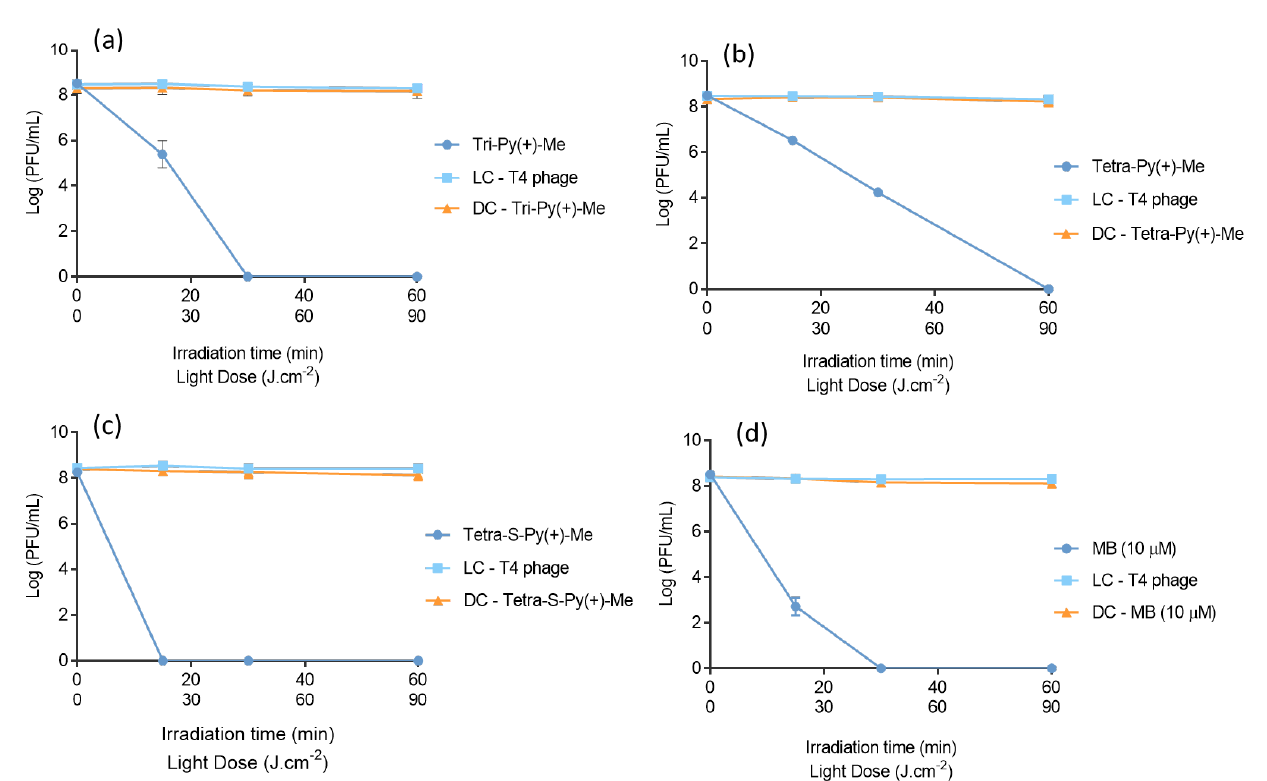
Figure 4. T4-like phage photoinactivation in PBS in the presence of ( a ) Tri-Py(+)-Me, ( b ) Tetra-Py(+)- Me, ( c ) Tetra-S-Py(+)-Me, and ( d ) MB at a concentration of 10 µM and under white light irradiation at an irradiance of 25 mW·cm − 2 . All values represent the average of three independent assays in duplicate. Error bars indicate the standard deviation and in some cases are collapsed with the sym- bols. Lines were used to connect the data points. LC — Light control; DC — Dark control.